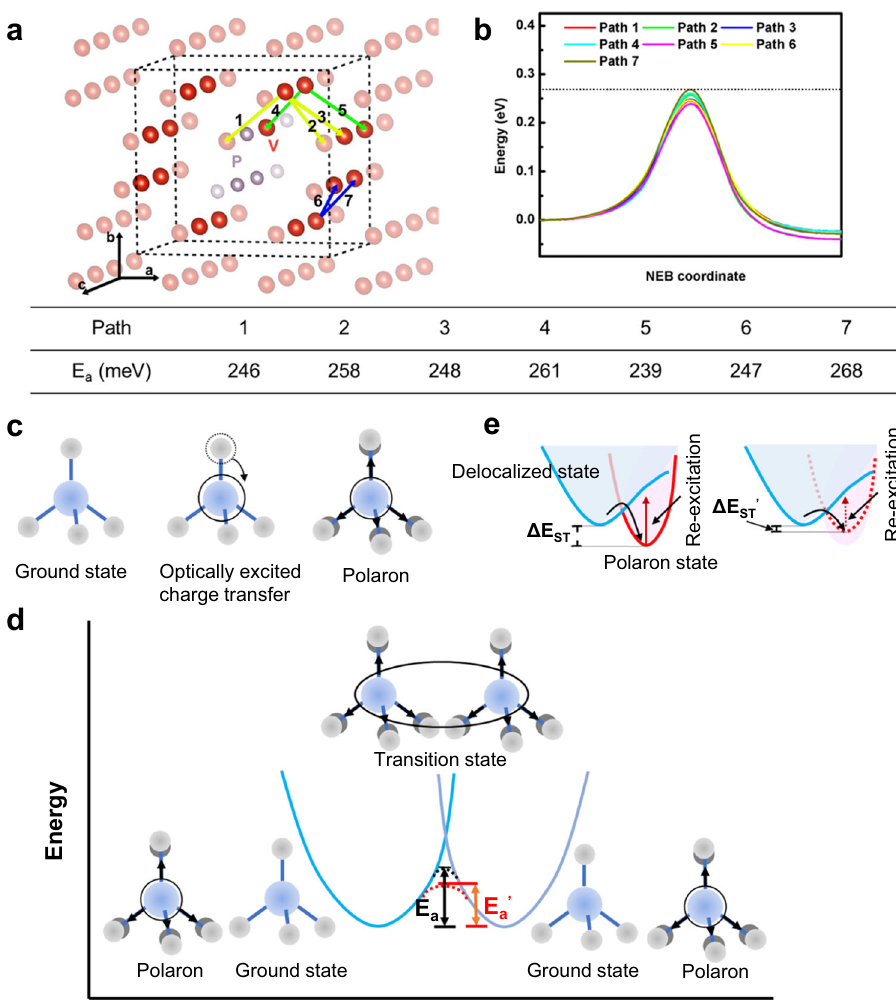
Fig. 6 | Small polaron hopping. a Schematic small polaron hopping paths in the phosphorus-doped BiVO 4 sample for DFT calculations. Only V (red) and phos- phorus (purple) atoms are displayed in the schematic structure model. Atoms highlighted are within the supercell and the rest are in the neighbor cells. The colored arrows are the selected hopping paths in the calculations. b Hopping energy barriers in phosphorus-doped BiVO 4 sample along the reaction coordina- tion of different reactionspaths. The dashed line representsthe hopping barrierin pristine BiVO 4 . The below table shows the hopping barriers of different paths in phosphorus-doped BiVO 4 . c Schematic small polaron formation: Initial excitation of BiVO 4 leads to a charge transfer transition from oxygen (light grey) to V atom (blue).Theinitialexcitedcarriersundergooptical-phononscattering,duringwhich the charge can be trapped in a small polaron, resulting the lattice expansion. Adapted and reprinted with permission from Rettie, A. J. E., Chemelewski, W. D., Emin, D. & Mullins, C. B. Unravelling small-polaron transport in metal oxide